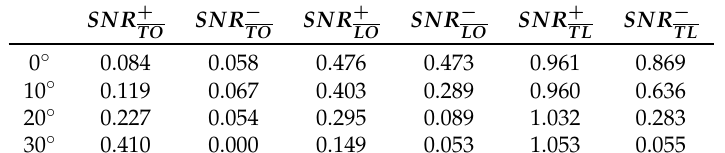
Table 4. SNR values calculated from the experimental error rates.